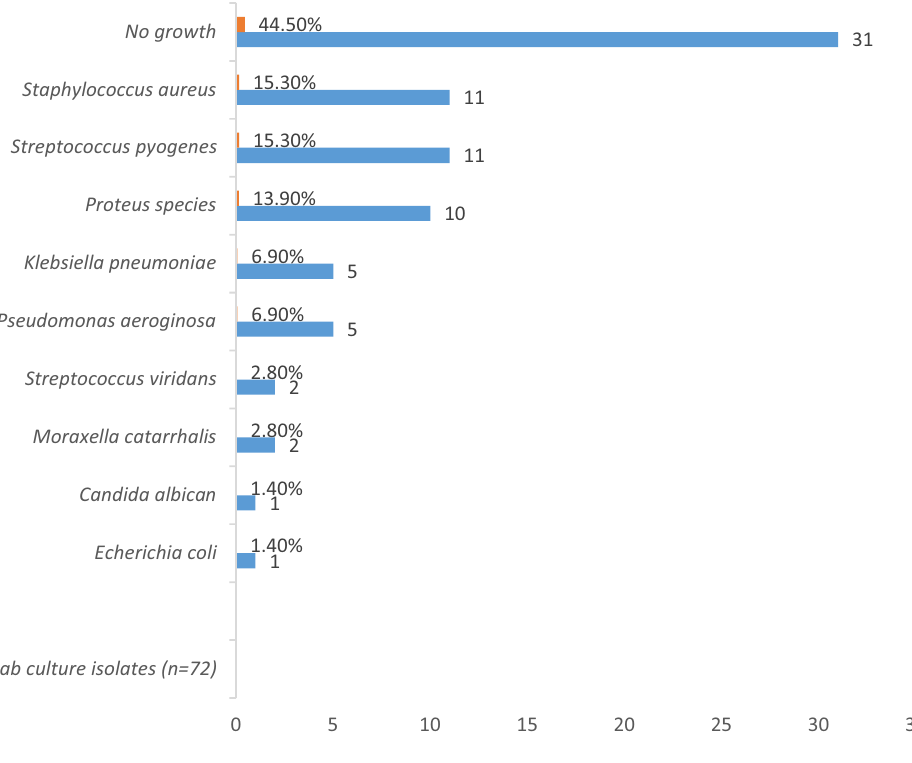
Figure 1. The microorganism isolates from the swab culture.